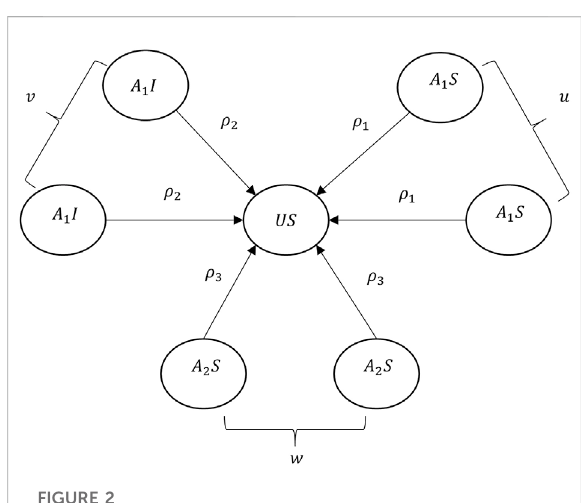
FIGURE 2 Sketch map of the awareness diffusion between unaware individuals and their aware neighbors. u , v , and w denote the number of A 1 S , A 1 I , and A 2 S , respectively. ρ 1 , ρ 2 , and ρ 3 are the health-related